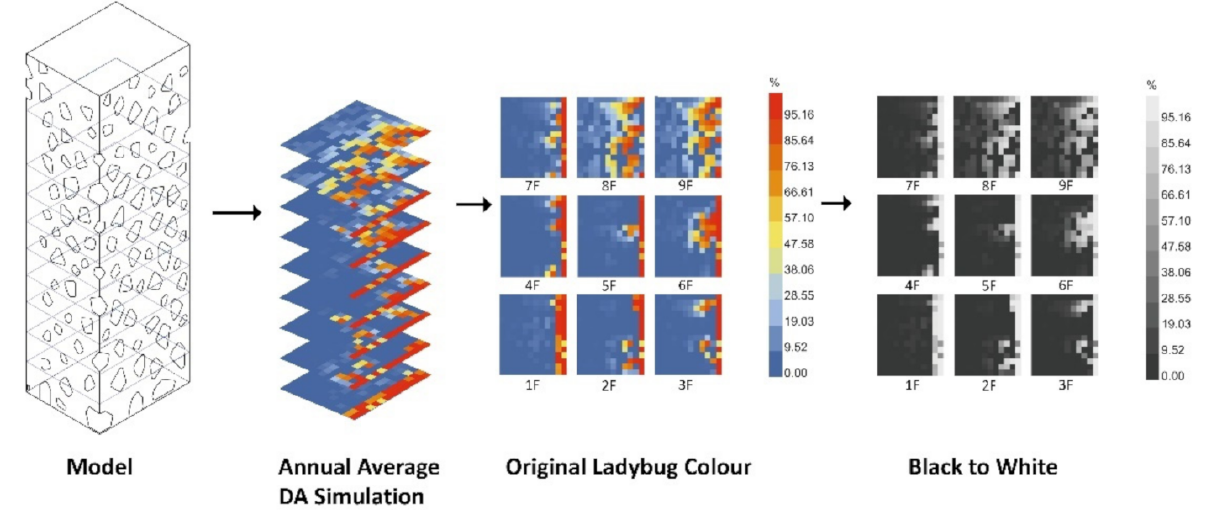
Figure 9. Daylight simulation showing daylight autonomy